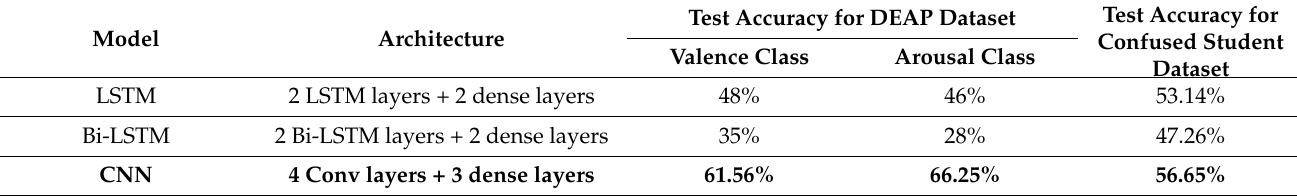
Table 6. Results summary of two-class classifications of valence and arousal from DEAP dataset and two-class classifications from confused student dataset with LSTM, BiLSTM, and CNN models using raw EEG